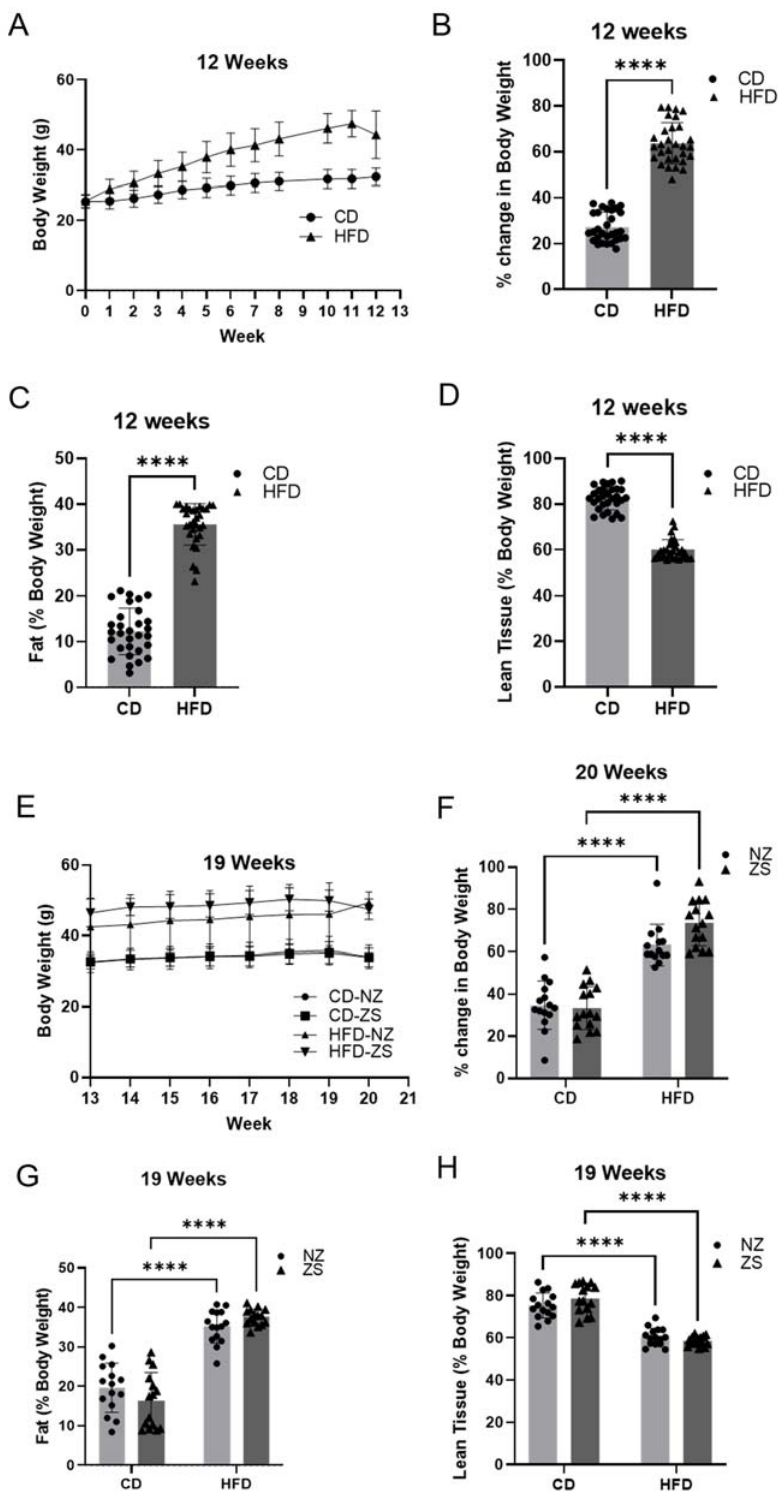
Figure 2. Effects of HFD and zinc supplementation on body weight and composition. 12 weeks of HFD resulted in significant body weight gain and altered body composition which zinc supple- mentation could not ameliorate. Body weights were measured weekly for duration of study and body composition determined by Echo MRI scan at weeks 12 and 19. Panels A – D show outcomes for weeks 1–12 (+/ − HFD). Panels E – H show outcomes for weeks 13–20 (+/ − HFD and +/ − zinc supplementation). Data are reported as mean ± SD (n = 30 mice/group, A – D ; n = 14–15 mice/group, E – H ) with significance set to 0.05. **** p < 0.0001. NZ = normal zinc, ZS = zinc